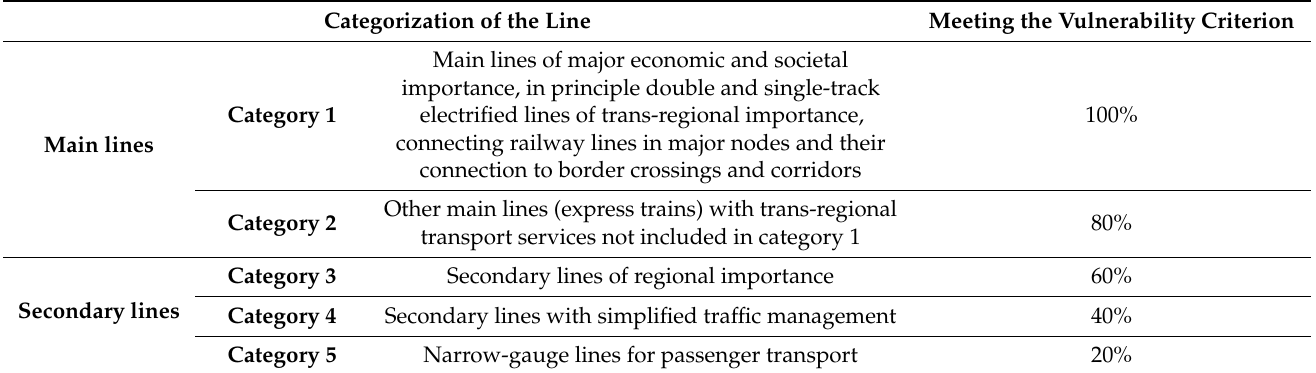
Table 10. Categorization of the